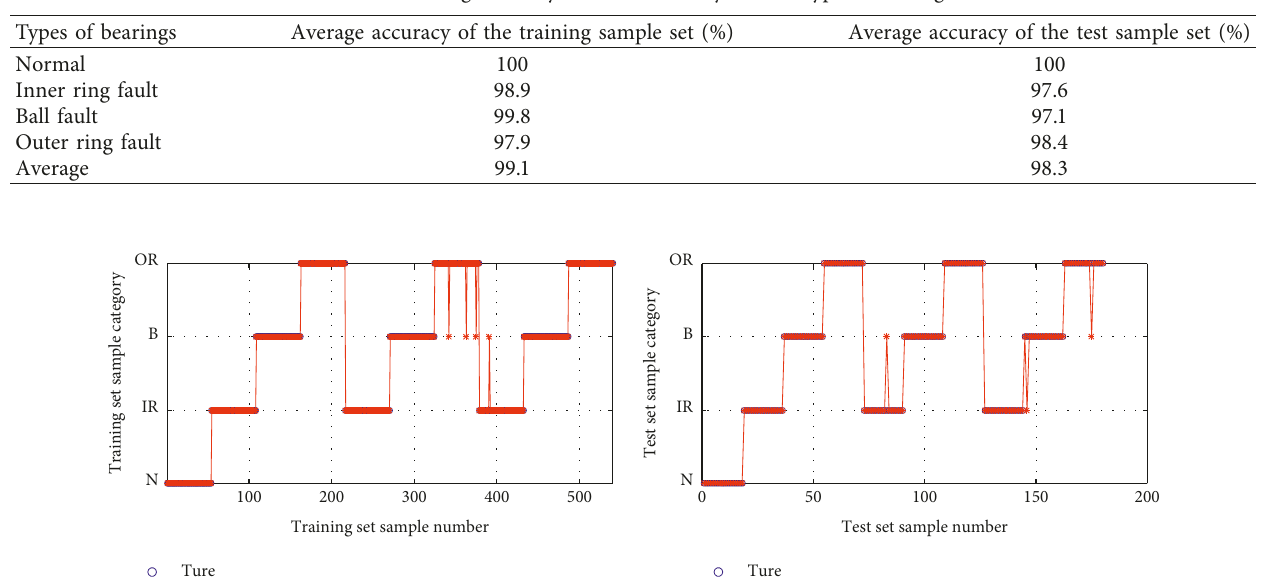
Figure 12: Optimal fitness value corresponding to the krill group movement under different impulse coefficients. Table 3: Training accuracy and test accuracy of each type of bearings.